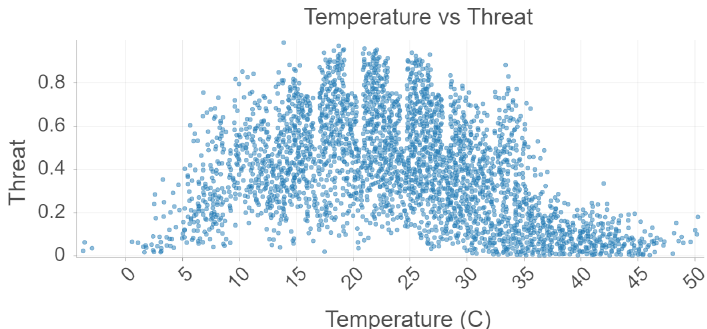
Figure 3. Temperature and Threat analysis using Random Forest.